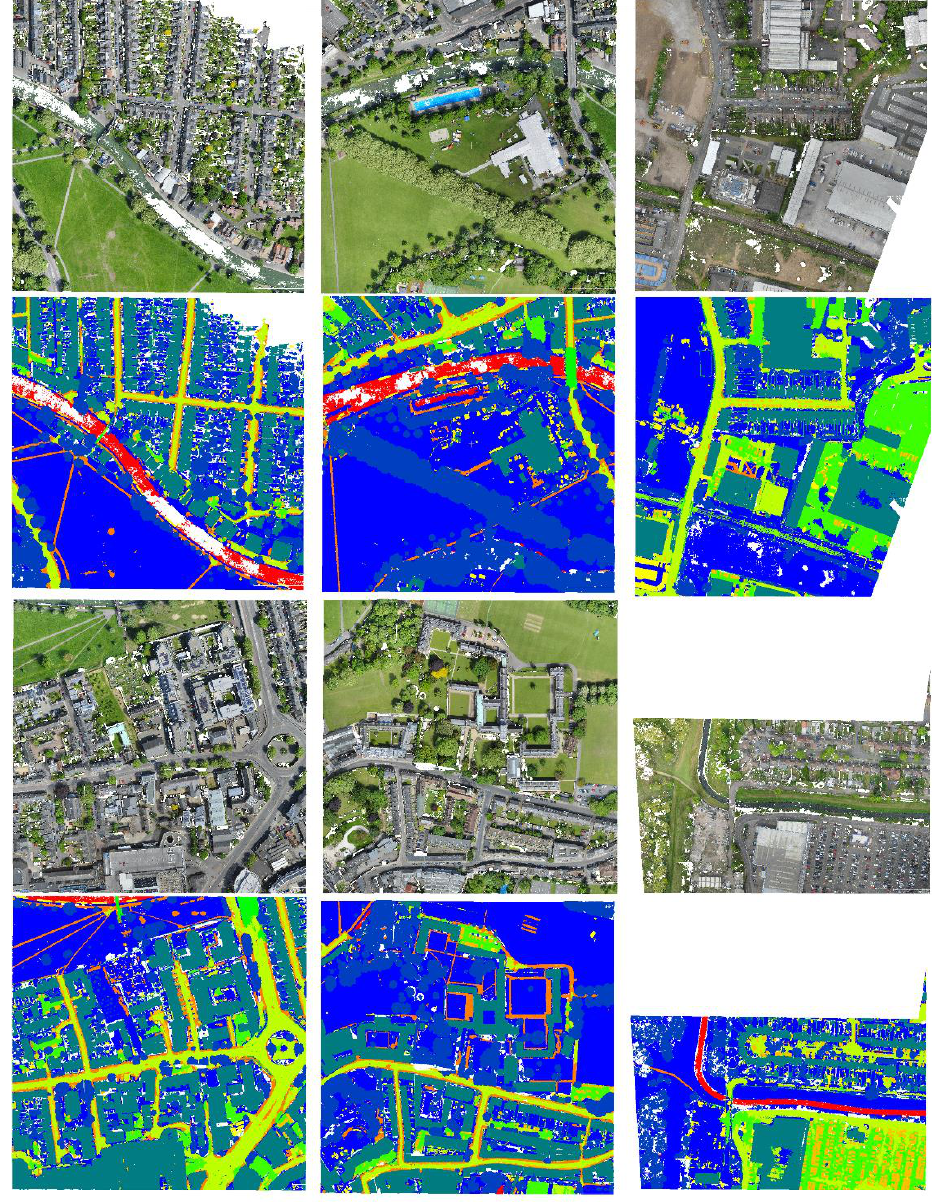
Figure 13. Semantic segmentation results for SensatUrban: The first and third rows show the original data. The second and fourth rows show the predicted results. Table 5 describes the detailed semantic segmentation metrics for SensatUrban. Our model achieved an mIOU of 56.92%. Table 5. Semantic segmentation results for SensatUrban.